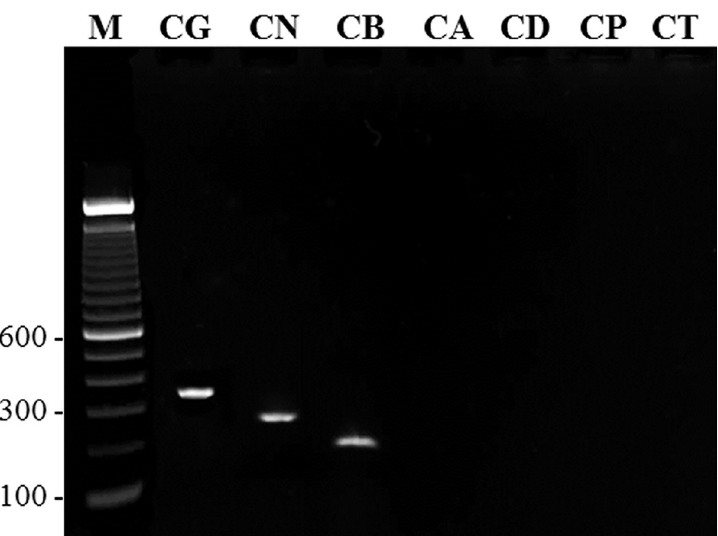
Fig 1. An agarose gel of amplified products obtained in mPCR using C . glabrata sensu stricto-specific (mCGLF), C . nivariensis -specific (mCNIF) and C . bracarensis -specific (mCBRF) forward and C . glabrata complex-specific (mCGCR) reverse primer with genomic DNA from reference strain of C . glabrata sensu stricto ATCC 90030 (lane CG), C . nivariensis CBS 9983 (lane CN), C . bracarensis CBS 10154 (lane CB), C . albicans ATCC 76615 (lane CA), C . dubliniensis CBS 7987 (lane CD), C. parapsilosis ATCC 22019 (lane CP) and C . tropicalis ATCC750 (lane CT). Lane M is 100 bp DNA ladder and the position of migration of 100 bp, 300 bp and 600 bp fragments are